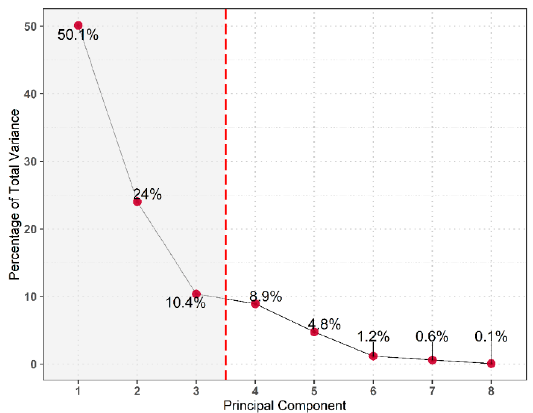
Figure 8. Scree plot of principal components and their share of explained sample variance. The shaded region behind the red line represents the total variance, ca. 85%, captured by PC1, PC2 and PC3.